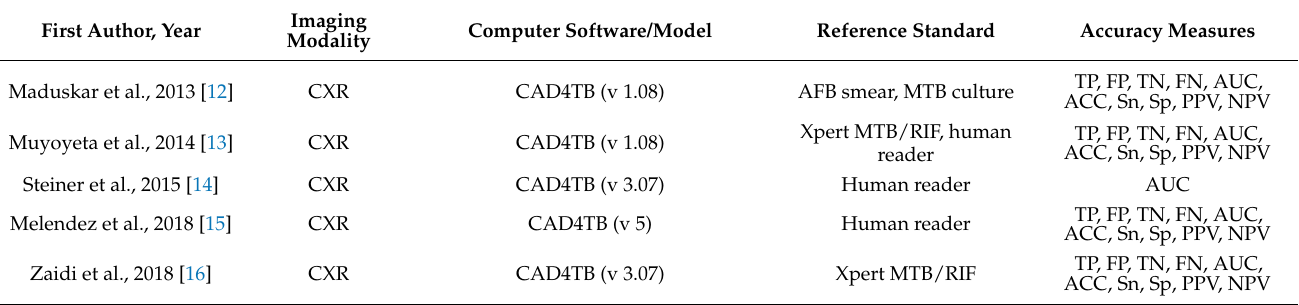
Table 1. Methods of studies included in descriptive